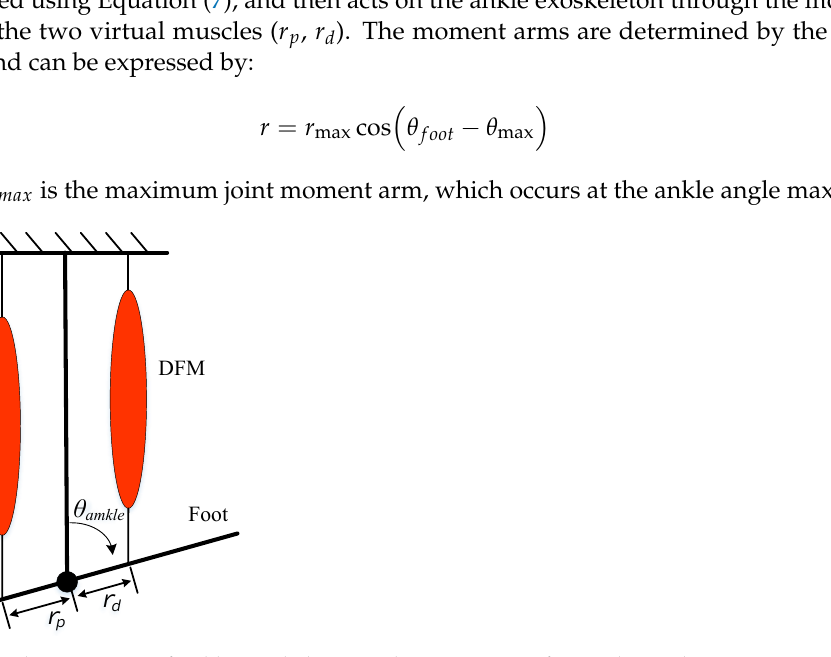
Figure 4. The geometry of ankle exoskeleton with two groups of virtual muscles. Form this, the desired assistance torque ( τ q ) produced by the two groups of virtual muscle can be calculated